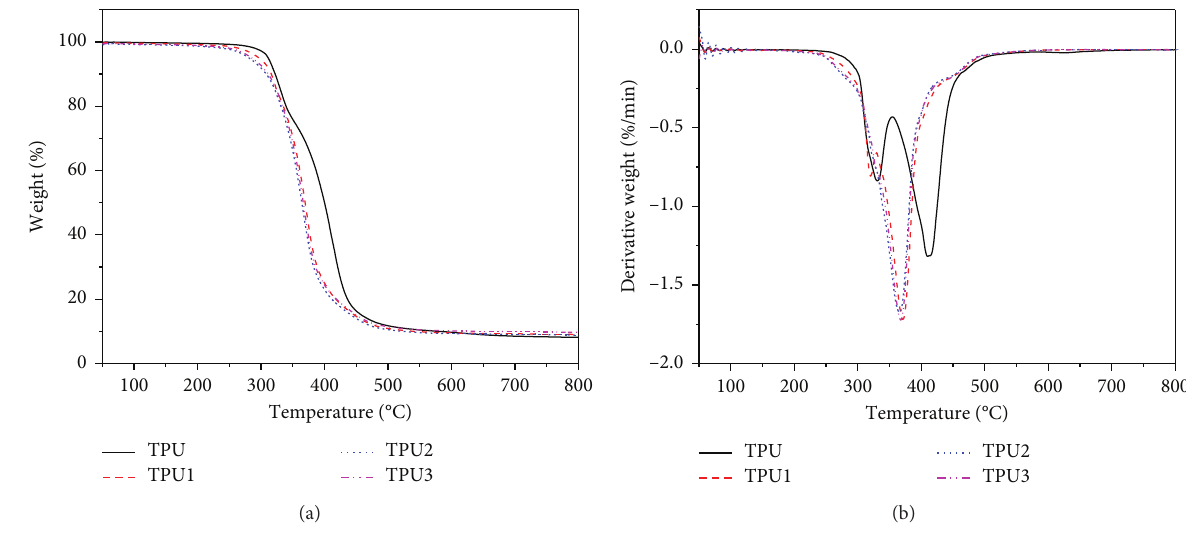
Figure 10: TGA (a) and DTG (b) curves of TPU and TPU composites. Table 3: TGA data of TPU and TPU composites in nitrogen